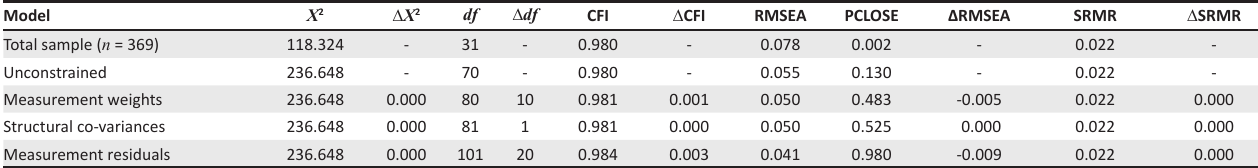
TABLE 1: Measurement invariance by academic achievement. Model